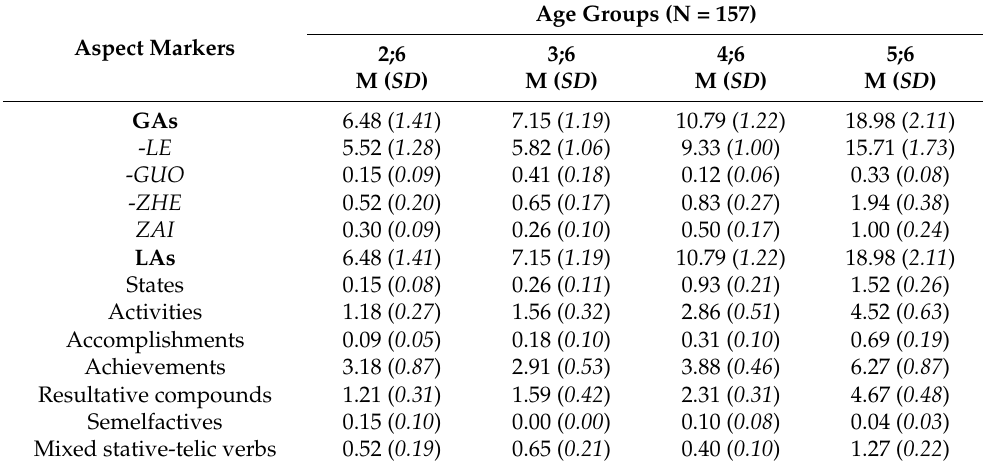
Table 2. Children’s Average Production of Aspect Markers in all age